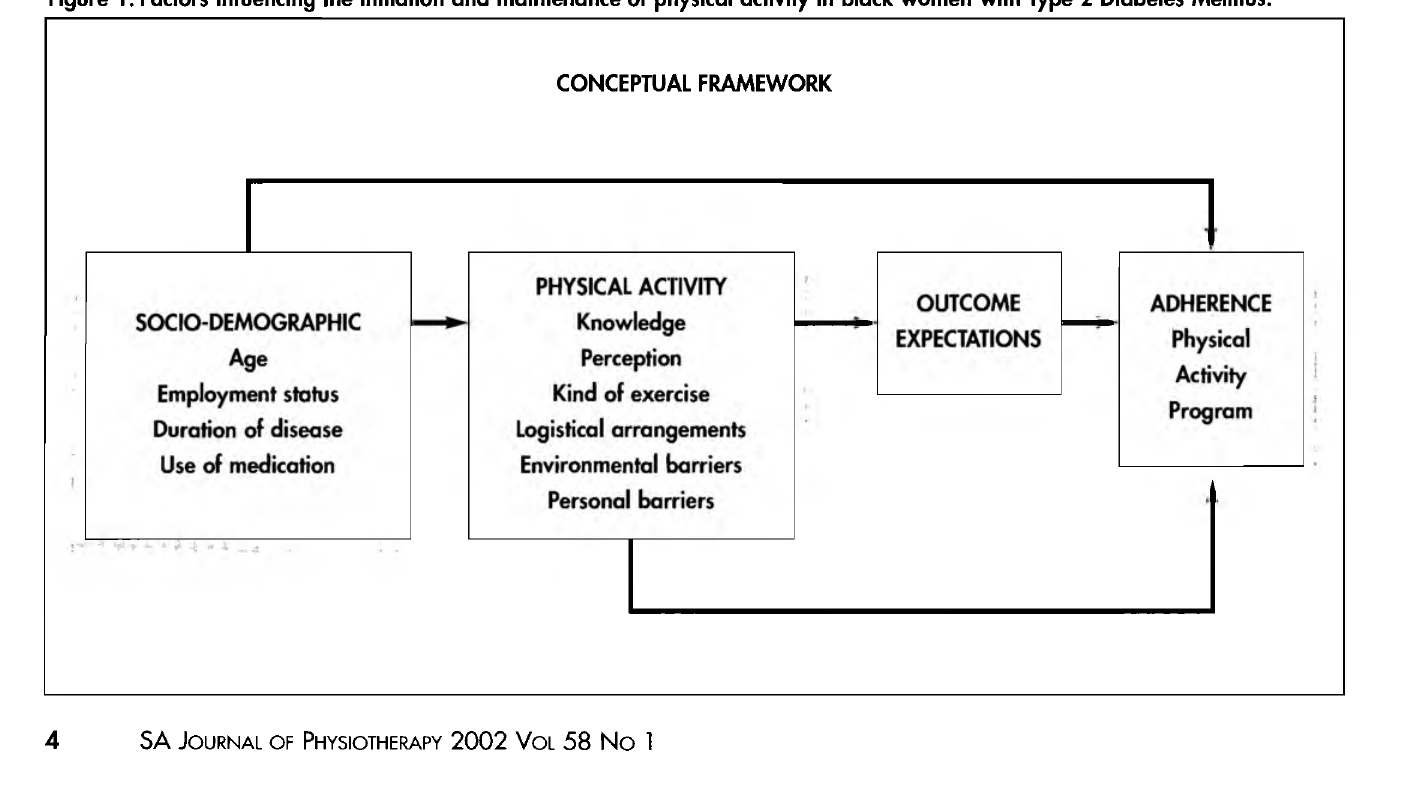
Figure 1: Factors infuencing the initiation and maintenance of physical activity in black women with Type 2 Diabetes